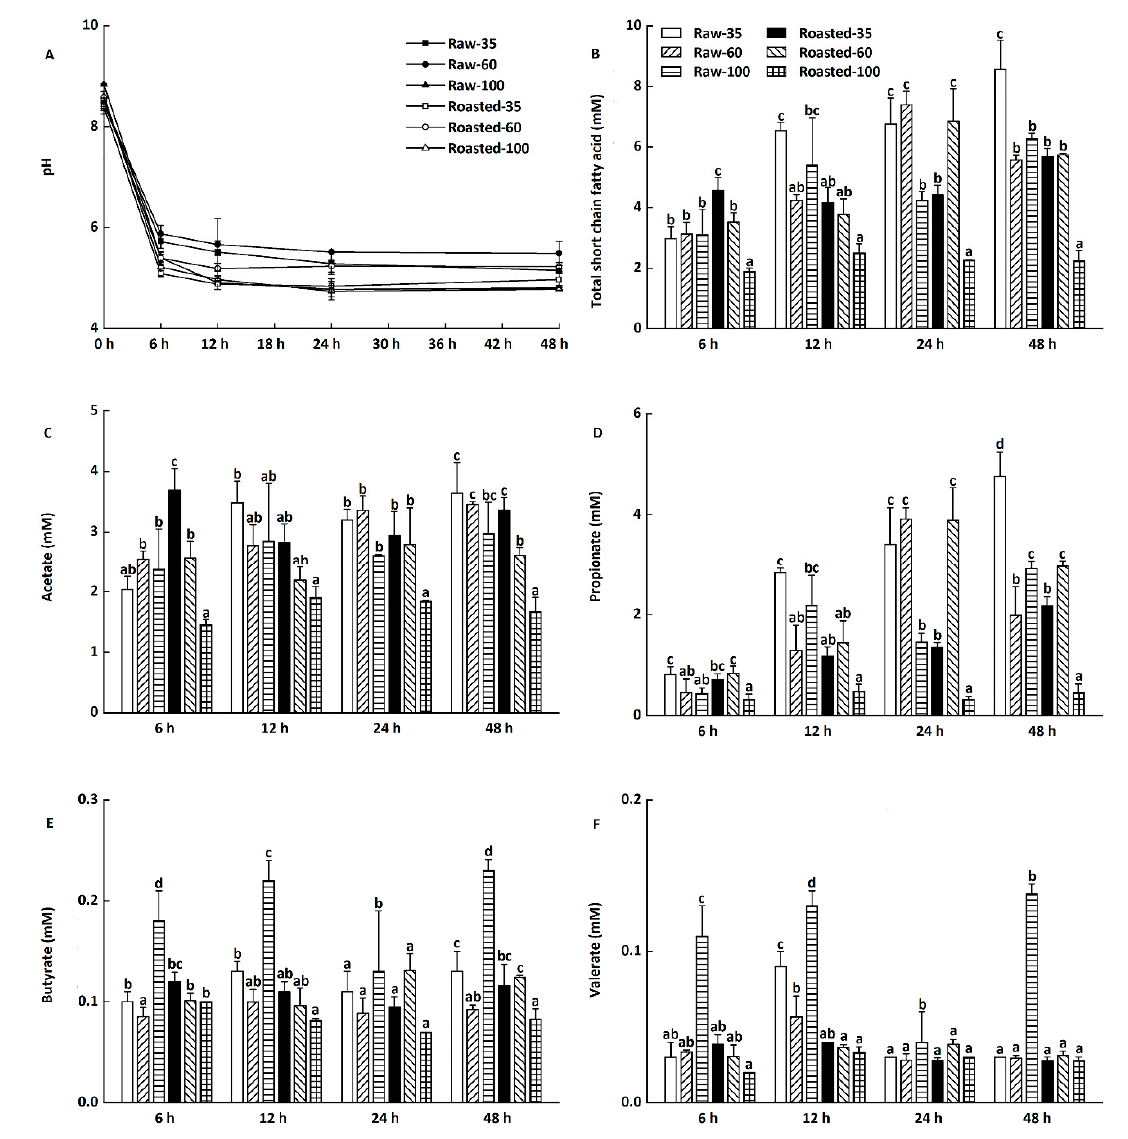
Figure 6. Changes of pH, total short-chain fatty acids (SCFAs), acetate, propionate, butyrate, and valerate during in vitro fermentation of highland barley flours. Raw-35, Raw-60, and Raw-100 indicate raw highland barley flour as coarse (250–500 µ m), medium (150–250 µ m), and fine (<150 µ m) fraction, respectively; while Roasted-35, Roasted-60, and Roasted-100 indicate roasted highland barley flour as coarse (250–500 µ m), medium (150–250 µ m), and fine (<150 µ m) fraction, respectively. a–d: Means with different letters differ significantly at each designated time ( p < 0.05). ( A ) Changes of pH by time points; ( B ) Changes of total SCFAs by time points; ( C ) Changes of acetate by time points. ( D ) Changes of propionate by time points; ( E ) Changes of butyrate by time points; ( F ) Changes of valerate by time points.